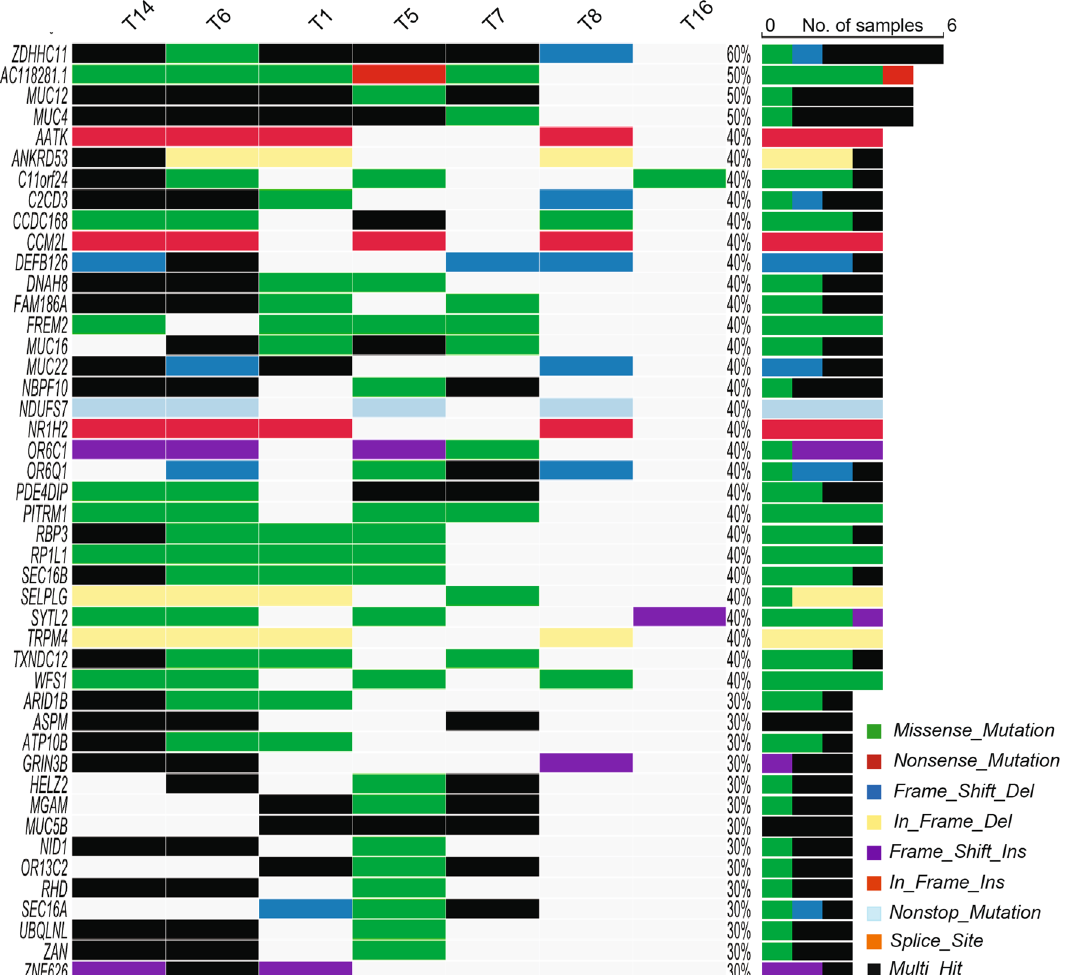
Figure 5. Single nucleotide variants of AA ESCC. Oncoplot by maftools was visualized mutations of missense, frameshift InDels, nonsense, splice site and translation start site that occurred in at least 30% of the tumors. Top 45 mutated genes were